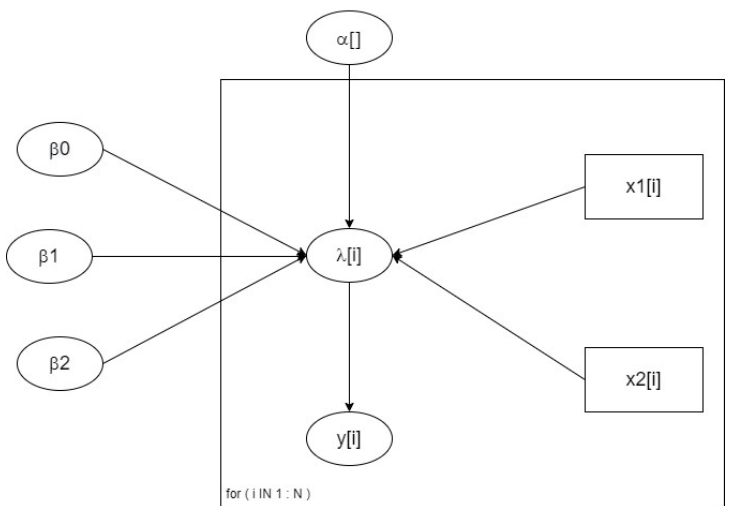
8 of 19 Figure 2. Monthly failure intensity in the study area.